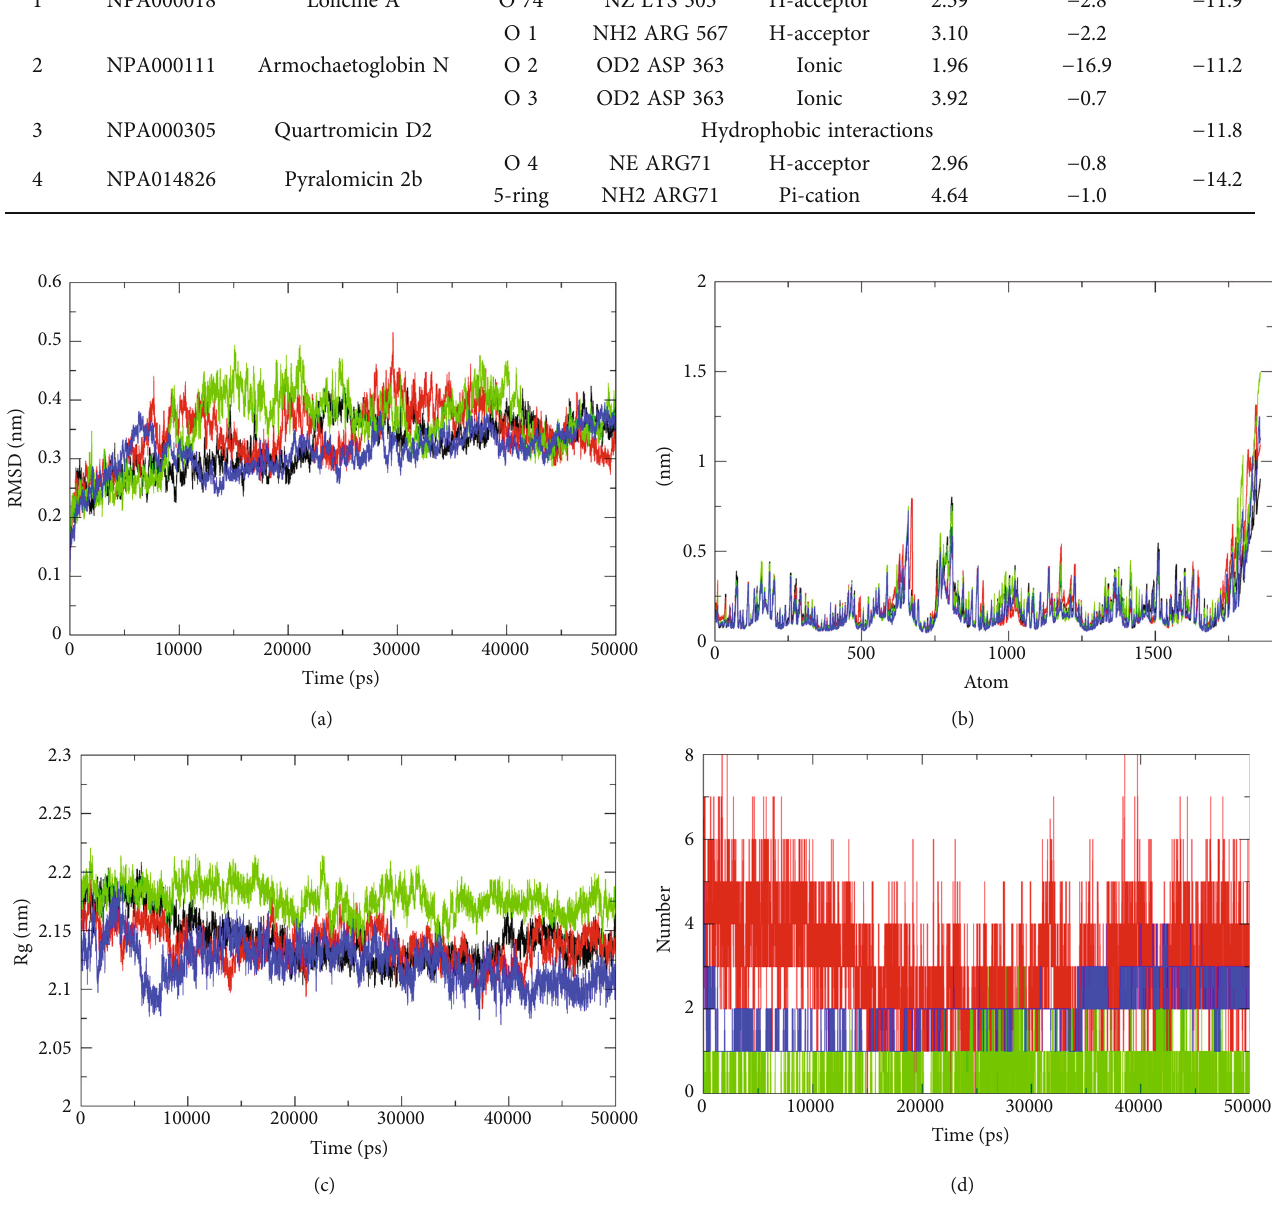
Figure 5: Molecular dynamics simulation study highlighting: (a) Root Mean Square Deviation (RMSD) of the protein backbone; (b) Root Mean Square Fluctuation of proteins after simulations; (c) radius of gyration of proteins (Rg), and; (d) hydrogen bonds identi fi ed in the shortlisted compounds i.e., NPA000018 (black), NPA000111 (red), NPA000305 (blue), and NPA014826